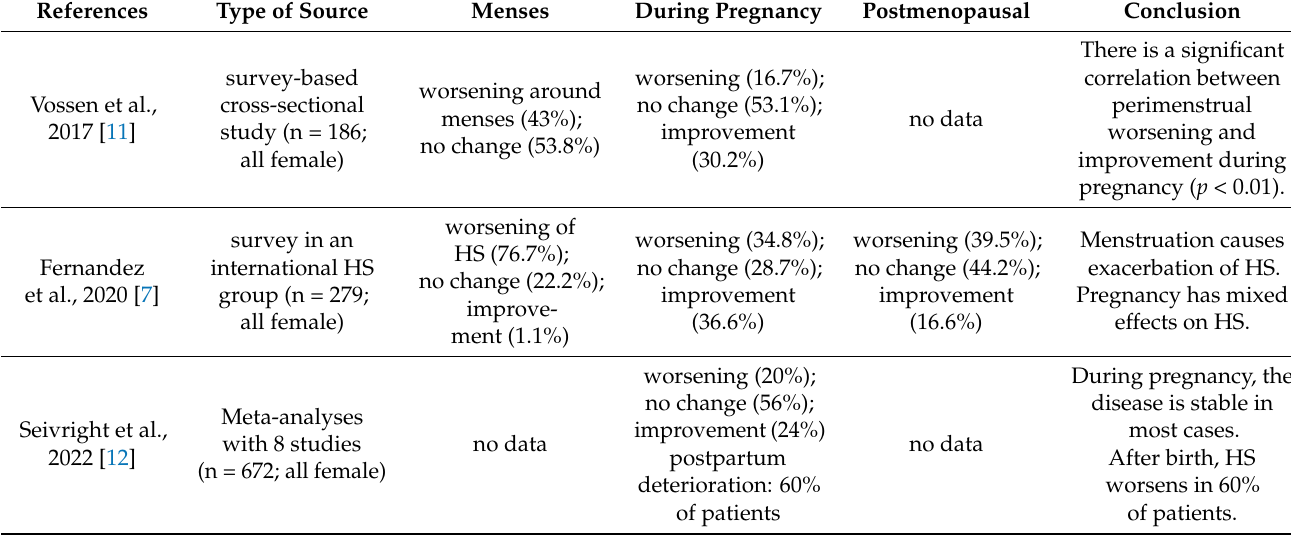
Table 1. Current findings about HS manifestation and